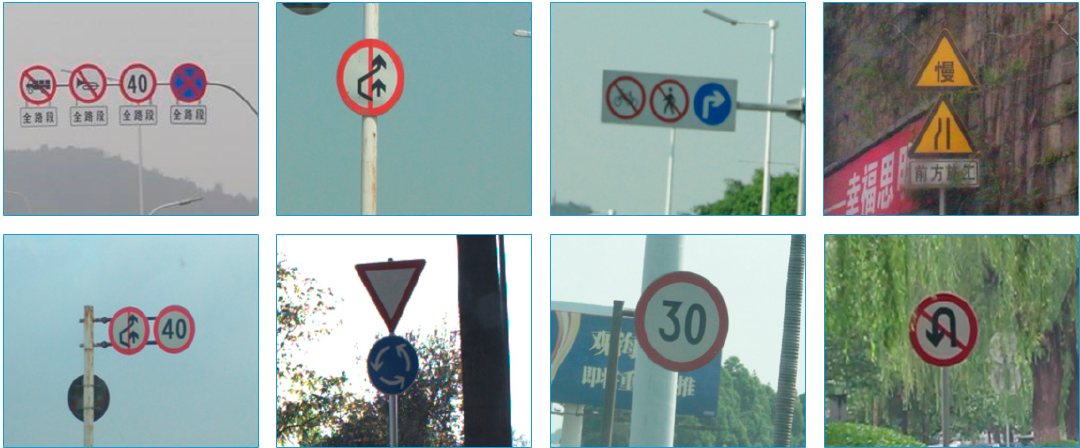
Figure 6. Examples of traffic signs with contextual information including other traffic signs, poles, etc.